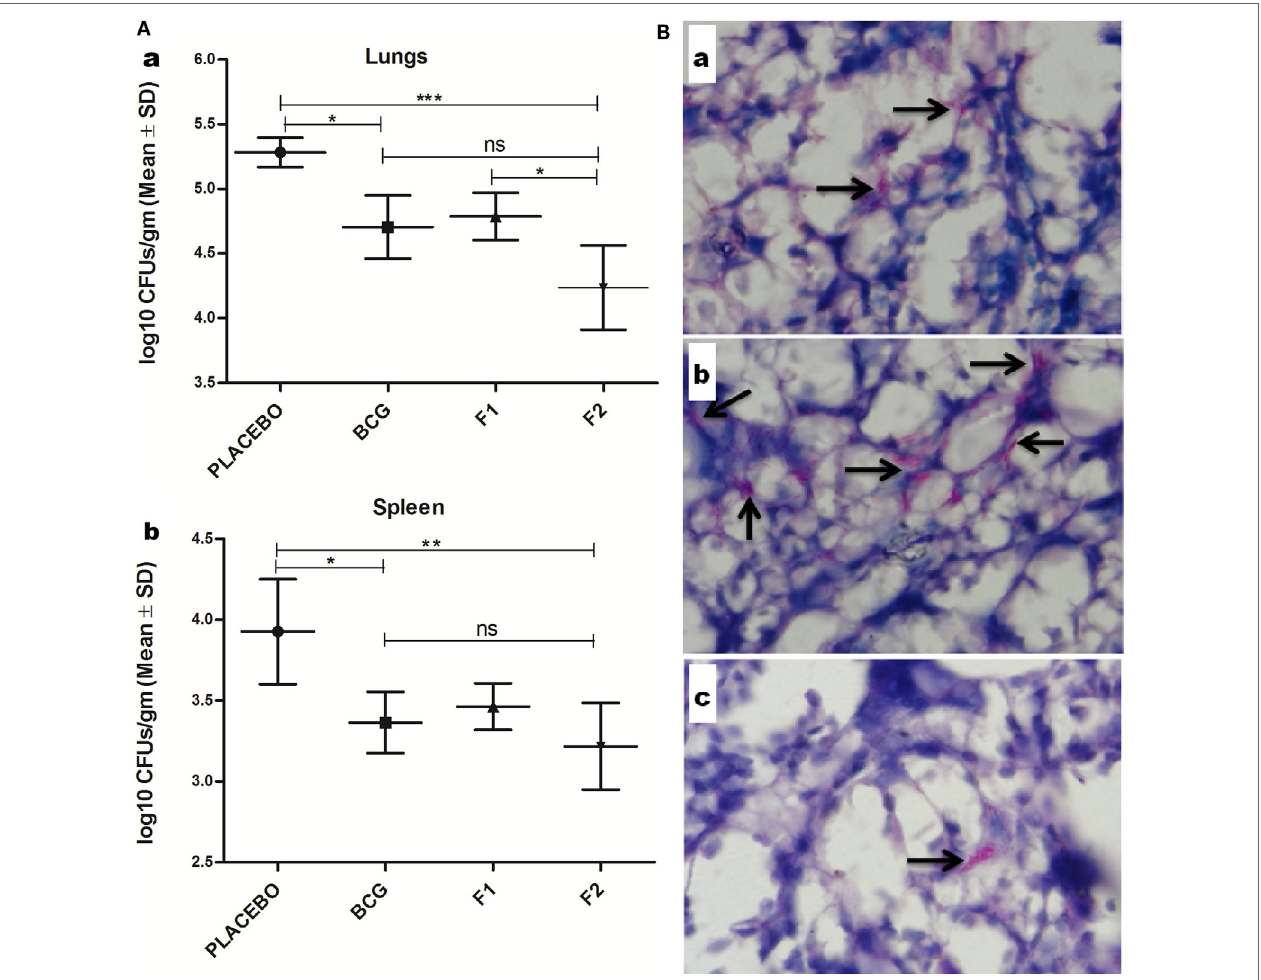
FigUre 10 | Evaluation of Mtb abundance in immunized mice at 10 weeks post infection. (a) Aggregated Ag85B suppresses Mtb bacillary load in the lungs and spleen of the immunized mice. Residual mycobacterial burden [colony-forming unit (CFUs)] in the lungs (a), and spleen (b) of the immunized animals was assessed at 10 weeks post infection. The colonies obtained were enumerated and expressed as log 10 CFUs/g of tissue. The data were analyzed by employing one-way ANOVA following by Bonferroni’s multiple comparison test where; p < 0.05(*), p < 0.01(**), and p < 0.001(***) were considered significant. The log 10 CFU data are expressed as means ( ± SD) of four animals in each group. (B) Histopathological analysis showing reduced residual mycobacterial burden in lungs of animals immunized with aggregated Ag85B. Representative histopathological photomicrographs from various immunized groups; (a) BCG, (b) Ag85B-IFA (F1), and (c) aggregated form of Ag85B(F2). Arrows pointing out relative occurrence of acid-fast bacilli positive bacilli ( Mtb ) in various immunized and infected groups at 10 weeks post aerosol challenge (Original magnification—1000 ×